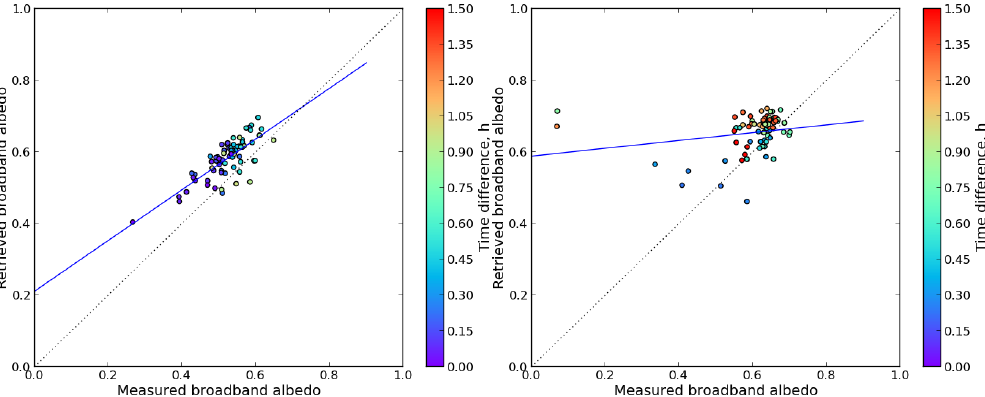
Figure 7. Correlation between broadband albedo retrieved from airborne measurements (MELTEX campaign) and from a satellite over- flight, respectively, for the 26 May 2008 (left panel), N = 73, R 2 = 0.61, RMS = 0.07 and 3 June 2008, (right panel), N = 78, R 2 = 0.05, RMS = 0.121, with respect to time difference. The flight on 3 June 2008 features the greatest time difference to the satellite overflight, therefore most of the points have been discarded due to possible drift contamination.